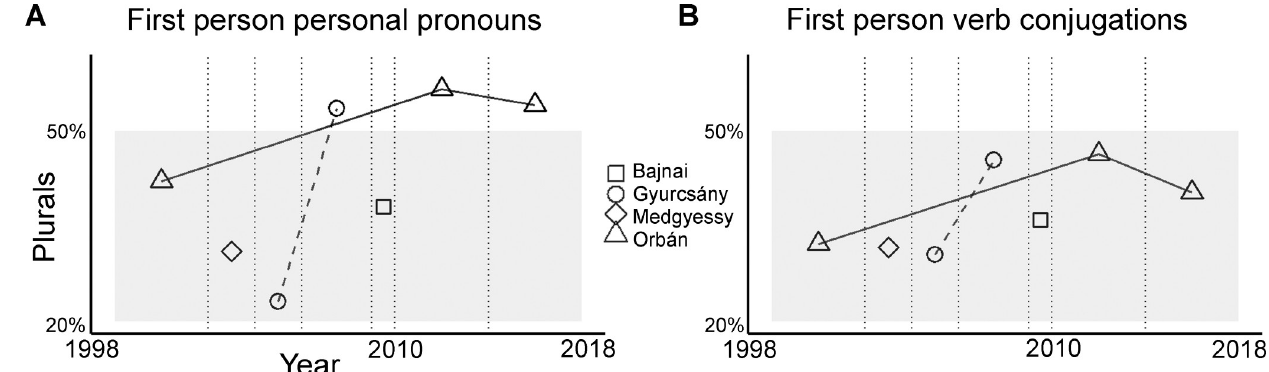
Fig 3. Percentage of plurals (WE). Percentages are shown A) within all first-person personal pronouns (“I” and “we”), and B) within first-person verb conjugations. Data shown for each parliamentary cycle (vertical dotted lines on y-axis) and for each PM (symbols).